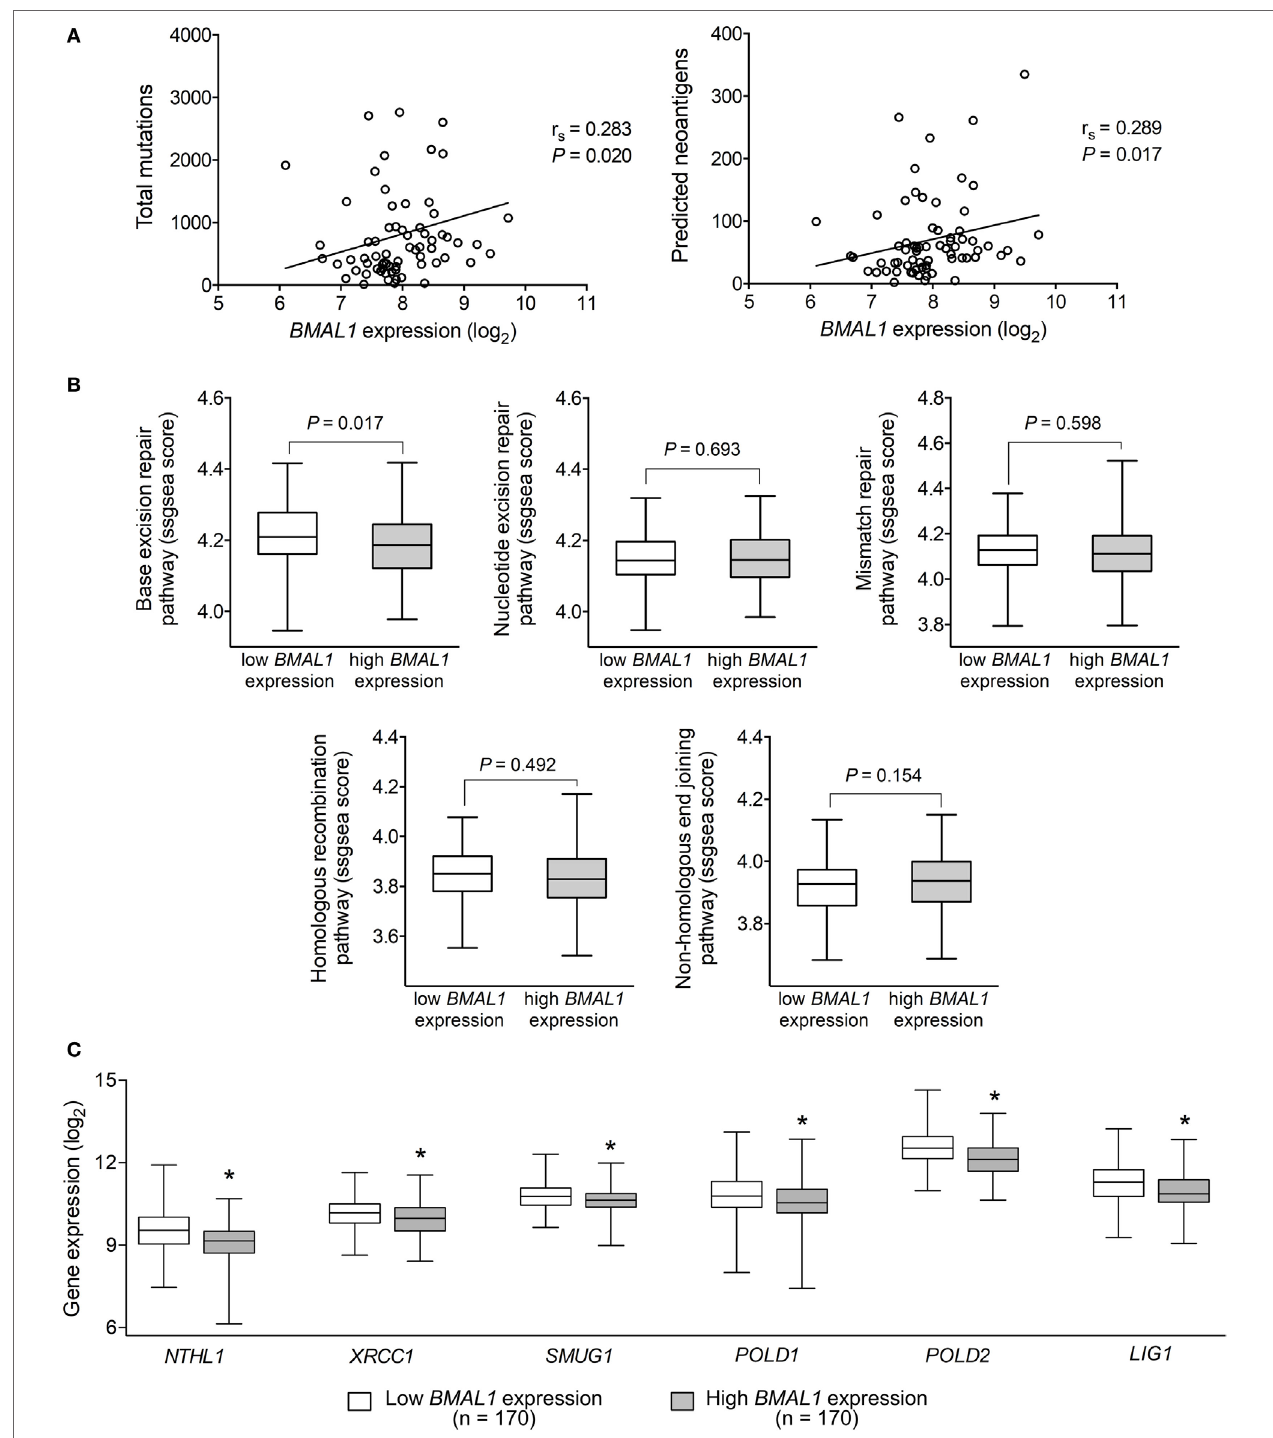
FigUre 3 | Aryl hydrocarbon receptor nuclear translocator-like protein 1 ( BMAL1 ) expression positively correlates with the mutational and neoantigen load in metastatic melanomas. (a) Spearman’s correlation between the expression of BMAL1 and the number of total mutations and predicted neoantigens in The Cancer Genome Atlas (TCGA) metastatic melanomas ( n = 68). NetMHCpan-predicted neoantigens were obtained from Ref. (40). Gene expression of (B) DNA-repair programs and (c) selected base excision repair enzymes according to the expression of BMAL1 in TCGA metastatic melanomas ( n = 340). Pathway scores were calculated using single sample Gene Set Enrichment Analysis available in the GSVA R package. The median expression of BMAL1 was used as the cutoff to dichotomize the population. The boxes extend from the 25th to the 75th percentile, the central bold line shows the median, and whiskers are drawn from minimum to maximum values. Comparisons were performed using the two-sided Wilcoxon–Mann–Whitney test. *Significantly different from the low BMAL1